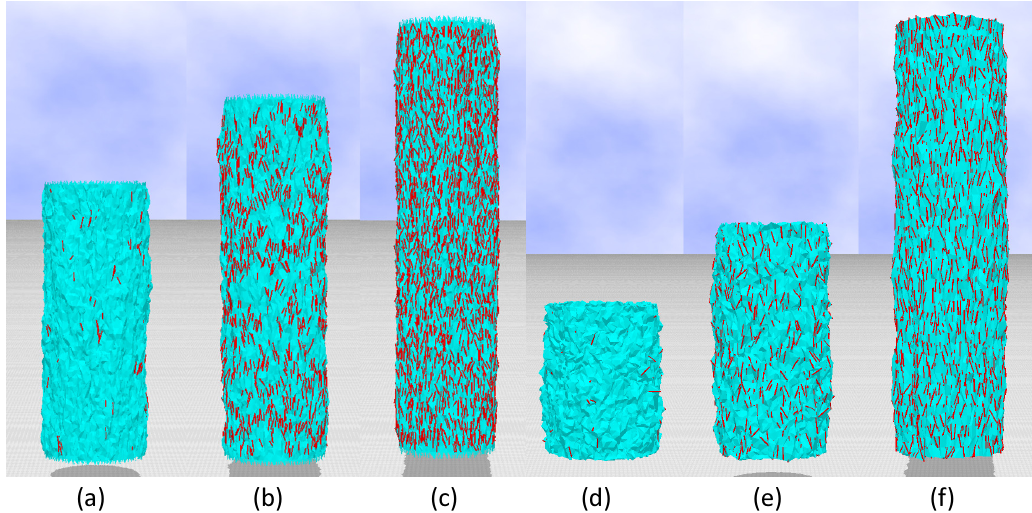
Figure 8. Snapshots of the ( a – c ) 2D empty model and ( d – f ) 3D model, where small red lines denote the crystalline bonds. The crystallization ratio is ( a ) χ (cid:39) 0.0035, ( b ) χ (cid:39) 0.060, ( c ) χ (cid:39) 0.12, ( d ) χ (cid:39) 0.0016, ( e ) χ (cid:39) 0.026, and ( f ) χ (cid:39)